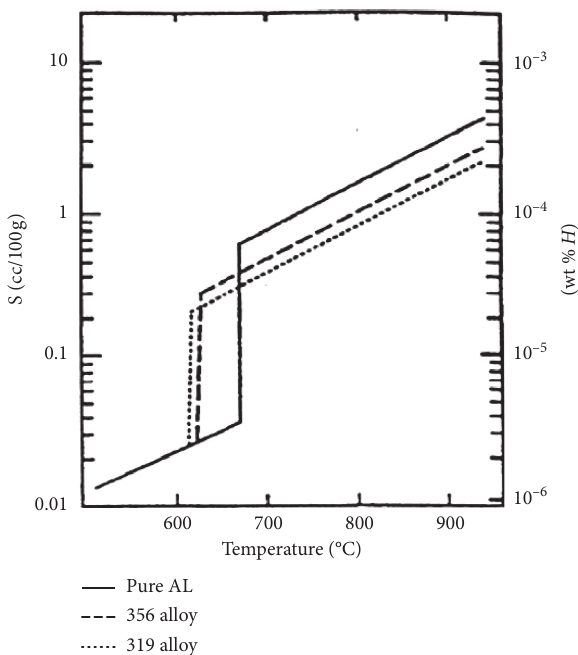
Figure 5: Hydrogen solubility of in pure aluminum, and Al-Si cast alloys